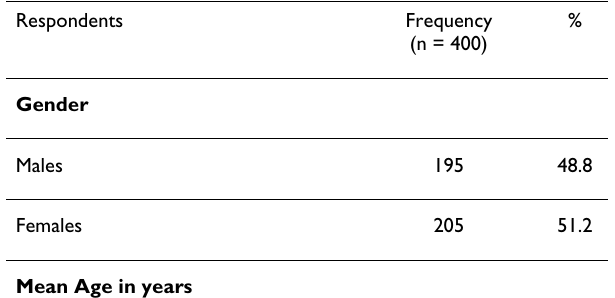
Table 1: Socio demographics of the